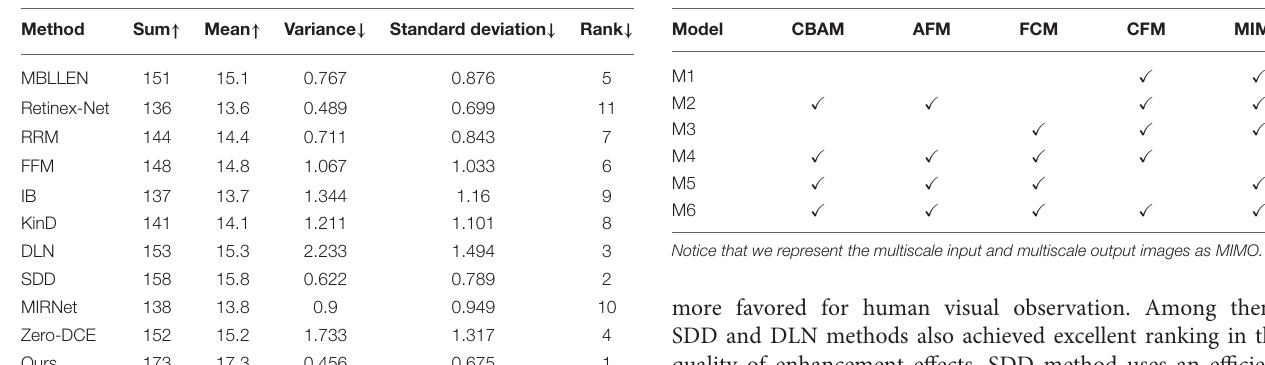
TABLE 5 | Validation of the rationality of the proposed network structure by adding and removing different modules in the ablation